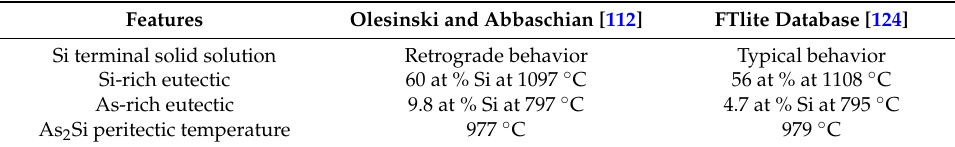
Table 5. Comparison between the available As-Si phase diagram